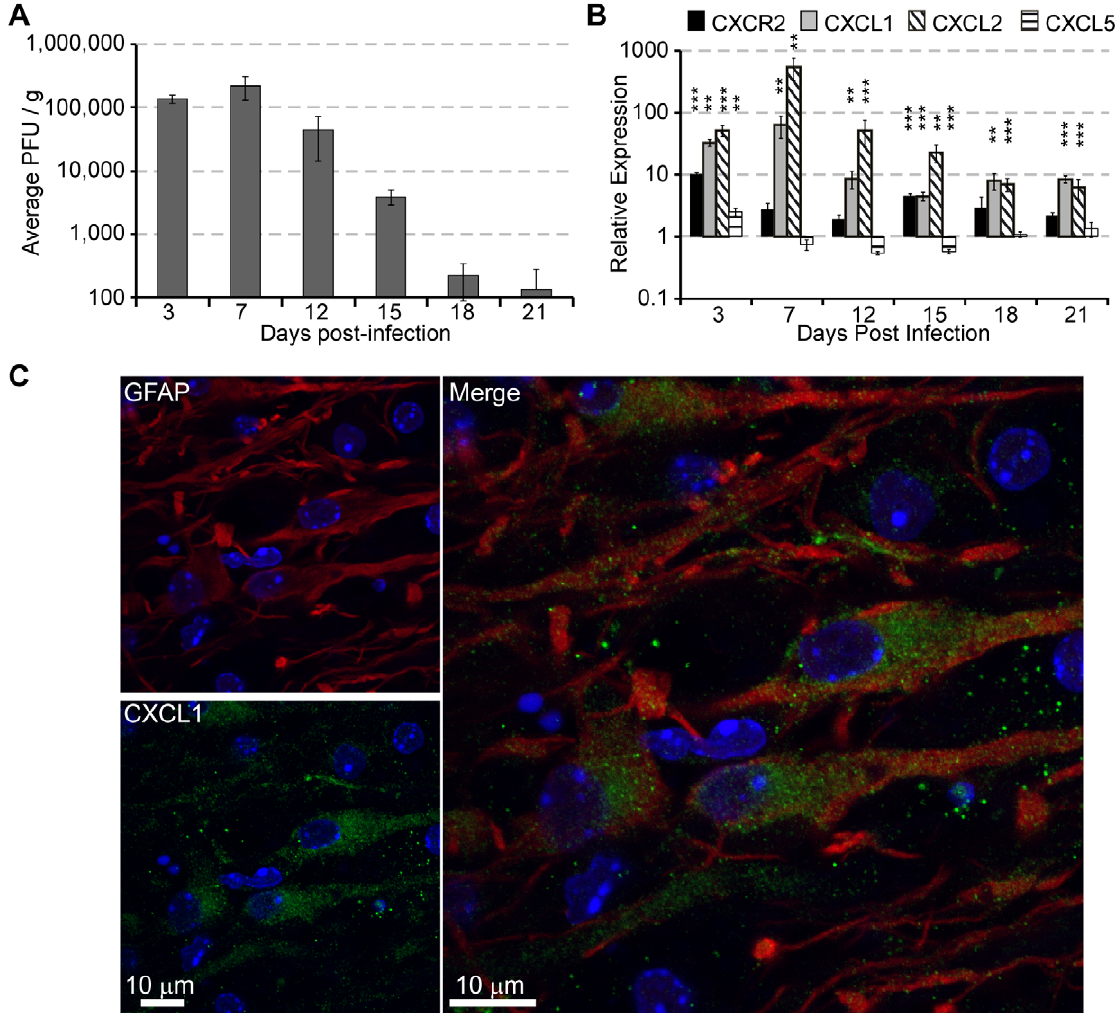
Figure 1. CXCR2 and ELR + chemokines are upregulated within the spinal cord during chronic JHMV infection. C57BL/6 mice were i.c. infected with 500 pfu JHMV and spinal cords removed at defined times p.i. to assess viral burden ( A ) and transcripts specific for CXCR2, CXCL1, CXCL2, and CXCL5 using semi-quantitative real time PCR ( B ). For PCR results, data represents the fold induction relative to sham infected mice (n=3– 5, * p , 0.05, ** p , 0.01, *** p , 0.001). Representative immunofluorescence of the spinal cord white matter at 15 days p.i reveals CXCL1 expression within reactive hypertrophic GFAP + astrocytes ( C ).